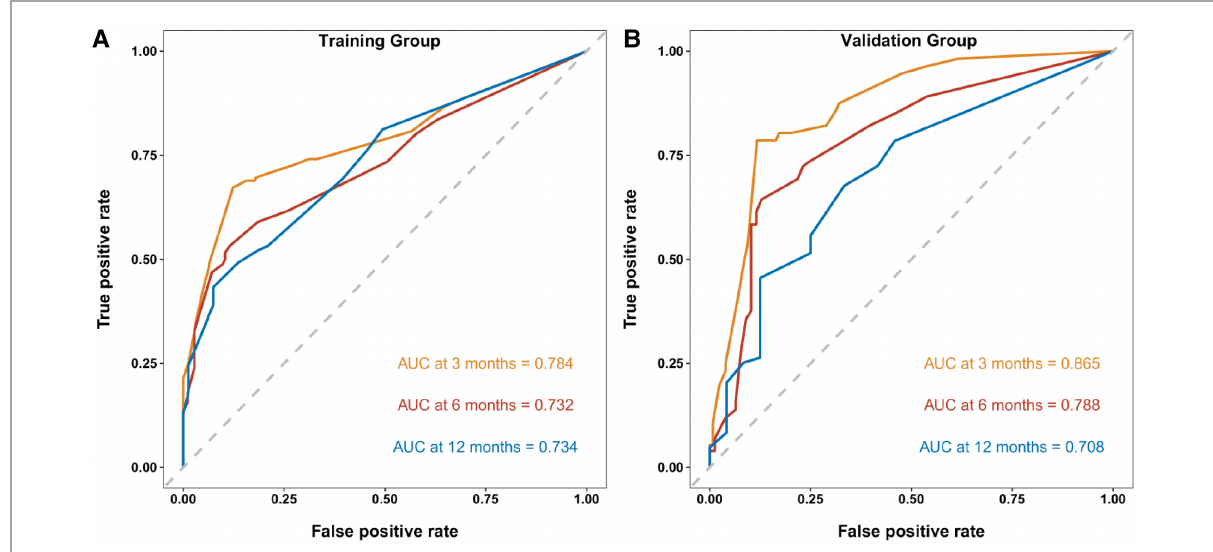
FIGURE 6 ROC curves of the prognostic model at 3, 6, and 12 months in the training group ( A ), and ROC curves of the prognostic model at 3, 6, and 12 months in the validation group ( B ).